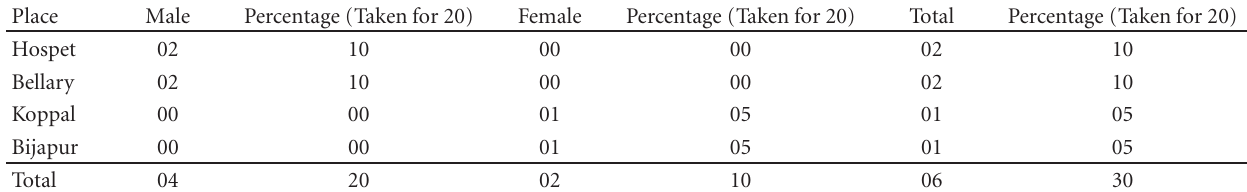
Table 4: Endemicity brucellosis in North